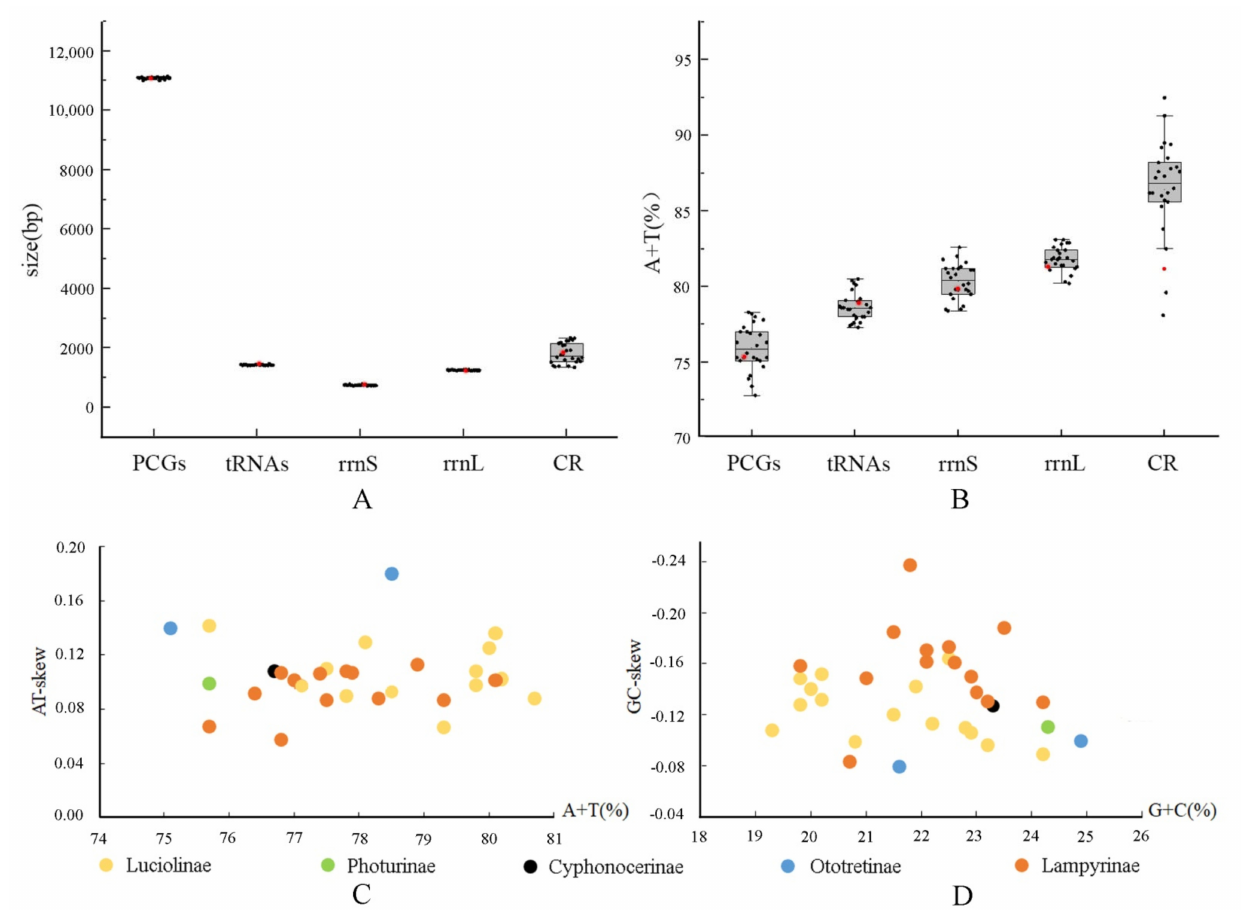
Figure 2. The size ( A ) and AT content ( B ) of PCGS, rrnL , rrnS , CR, and tRNA of 33 firefly species with the red dots representing C. sanguineus klapperichi (lower edge of the gray rectangle, 25 percentile; central black bar within the rectangle, median; upper edge of the rectangle, 75 percentile); Nucleotide composition of 33 complete firefly species, with the black dots representing the C. sanguineus klapperichi : ( C ) the A+T content and AT skew; ( D ) the G+C content and GC-skew.